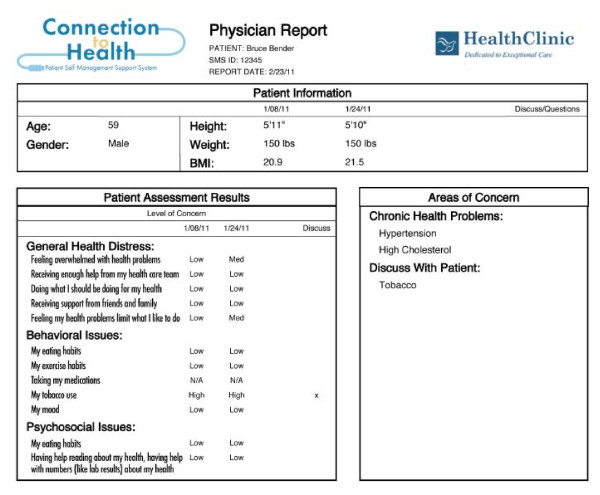
Physician report.